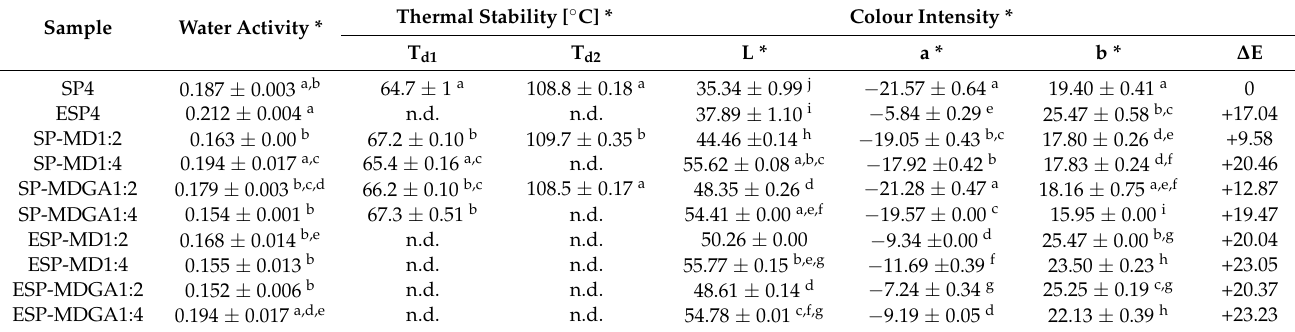
Table 1. Physical properties of microencapsulated Arthrospira platensis